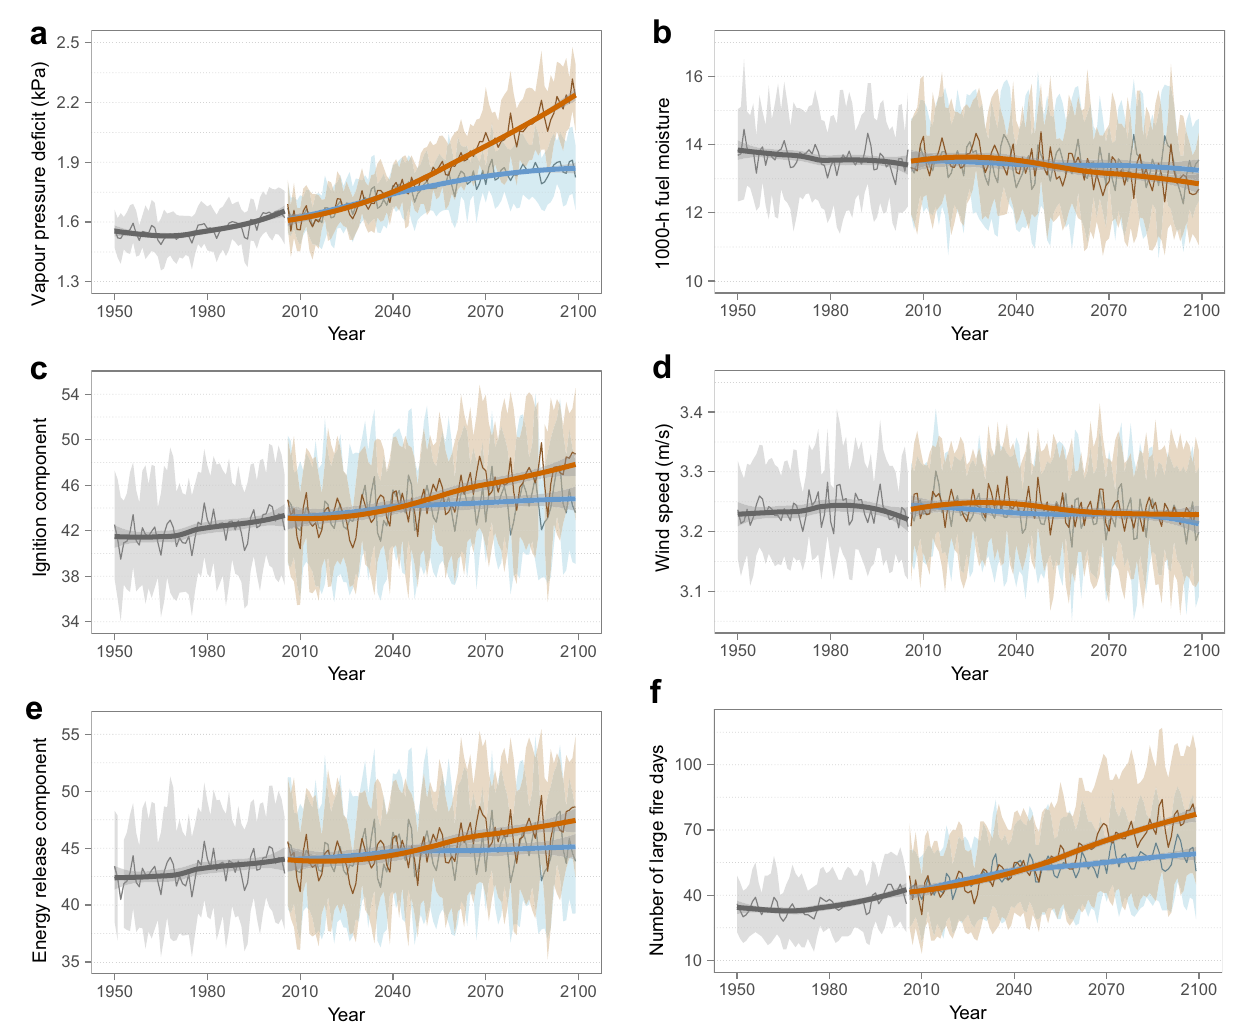
Fig. 4 Earth system model (ESM) ensemble means of the top- fi ve key predictors and the simulated annual number of large fi re days. a vapour pressure de fi cit (VPD), b 1000-h dead fuel moisture (F1000), c ignition component (IC), d wind speed (WS), e energy release component (ERC), f number of large fi re days. Both the historical (grey, 1950 – 2005) and future (blue/tan, 2006 – 2099, left: moderate emission scenario, RCP4.5, right: high emission scenario, RCP8.5) variations of these variables are shown. Shaded areas represent ±1 standard deviation. A low-pass fi lter was applied to remove the highest 20% frequencies to reduce noise in the time series. Bold lines (grey: historical, blue: RCP4.5, orange: RCP8.5) refer to locally weighted smooth series with the 95% con fi dence intervals